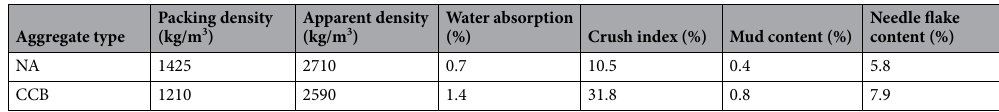
Table 1. Coarse aggregate performance